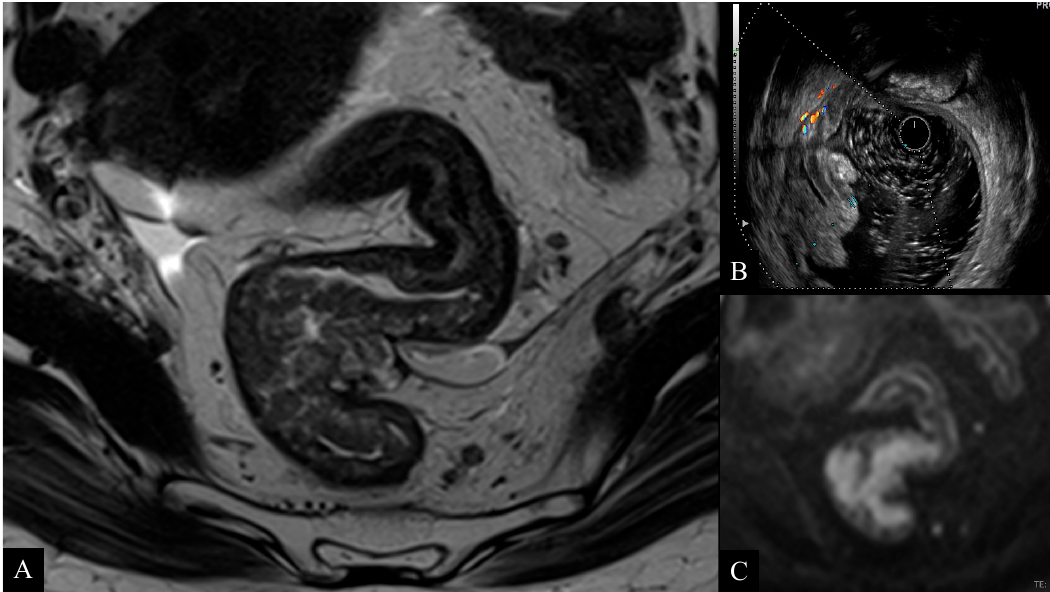
Figure 5. 67-year-old woman with high rectal cancer. Axial T2-weighted image ( A ) obtained with MRI shows a large circumferential tumor infiltrating the muscolaris propria layer and close to the anterior peritoneal reflection. ERUS scan ( B ) and axial diffusion weighted imaging (DWI) ( C ) images confirm the presence of a tumor infiltrating the rectal wall with focal invasion to the perirectal fat. Pathology examination confirmed the presence of a T3b tumor.